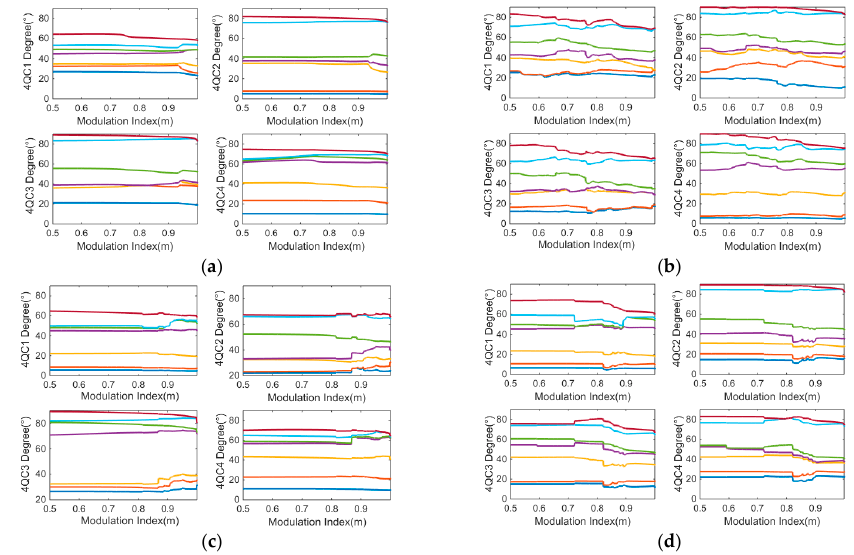
Figure 13. Switching angle illustration with different elimination harmonics frequency group: ( a ) 3–35, 37–45; ( b ) 3–35, 47–55; ( c ) 3–35, 57–65; and ( d ) 3–35, 67–75.